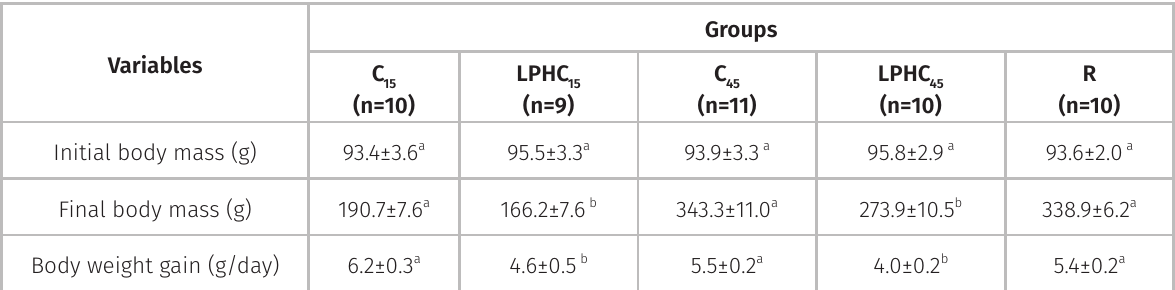
, LPHC , C , LPHC , and R groups. 15 15 45 45 Groups